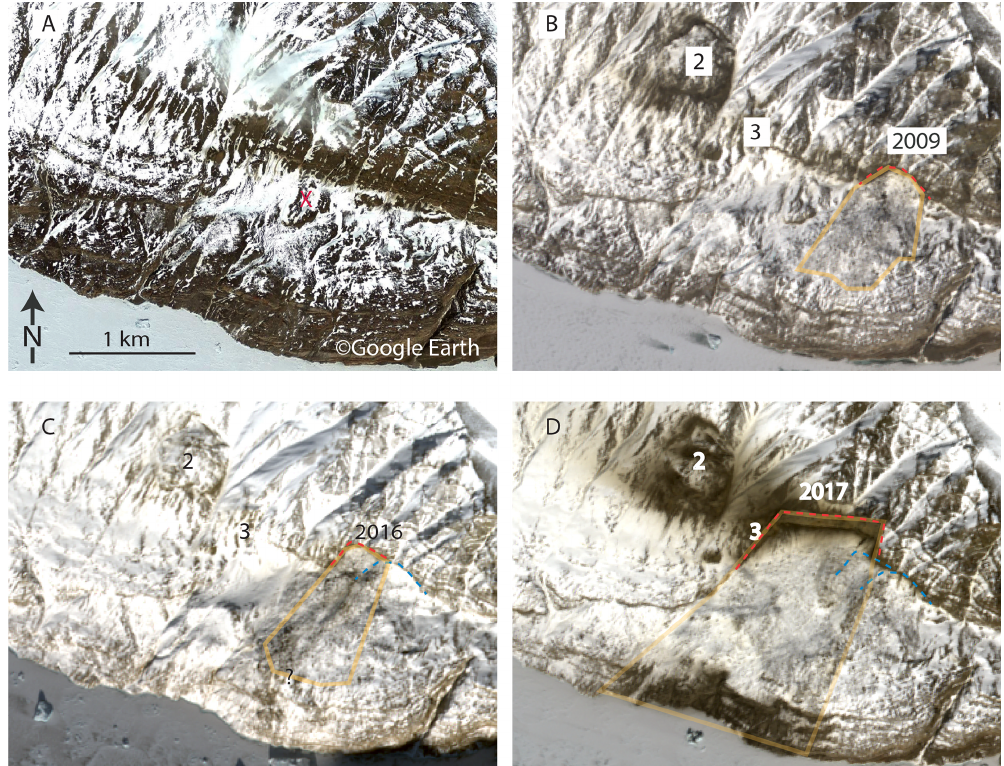
Figure 4. Optical satellite images of the eastern part of the Karrat Landslide Complex, the locus of recent rock avalanches. (a) Scene from 1 May 2009 before the rock avalanche; a presumed older rock avalanche deposit (lobe) is marked with X, same as Fig. 1b (from © Google Earth; image credit: Maxar Technologies). (b) Sentinel-2 image from 5 April 2016 showing the situation after the Karrat 2009 rock avalanche of 1 September 2009 at 14:09Z. (c) Sentinel-2 image from 1 March 2017 showing the situation after the Karrat 2016 rock avalanche of 11 November 2016 at 14:09Z. (d) Sentinel-2 image from 10 April 2018 showing the situation after the Karrat 2017 rock avalanche of 17 June 2017 at 23:39Z. Scarp (red) of the 2017, 2016, and 2009 rock avalanches and depositional lobes (orange) are shown with bold